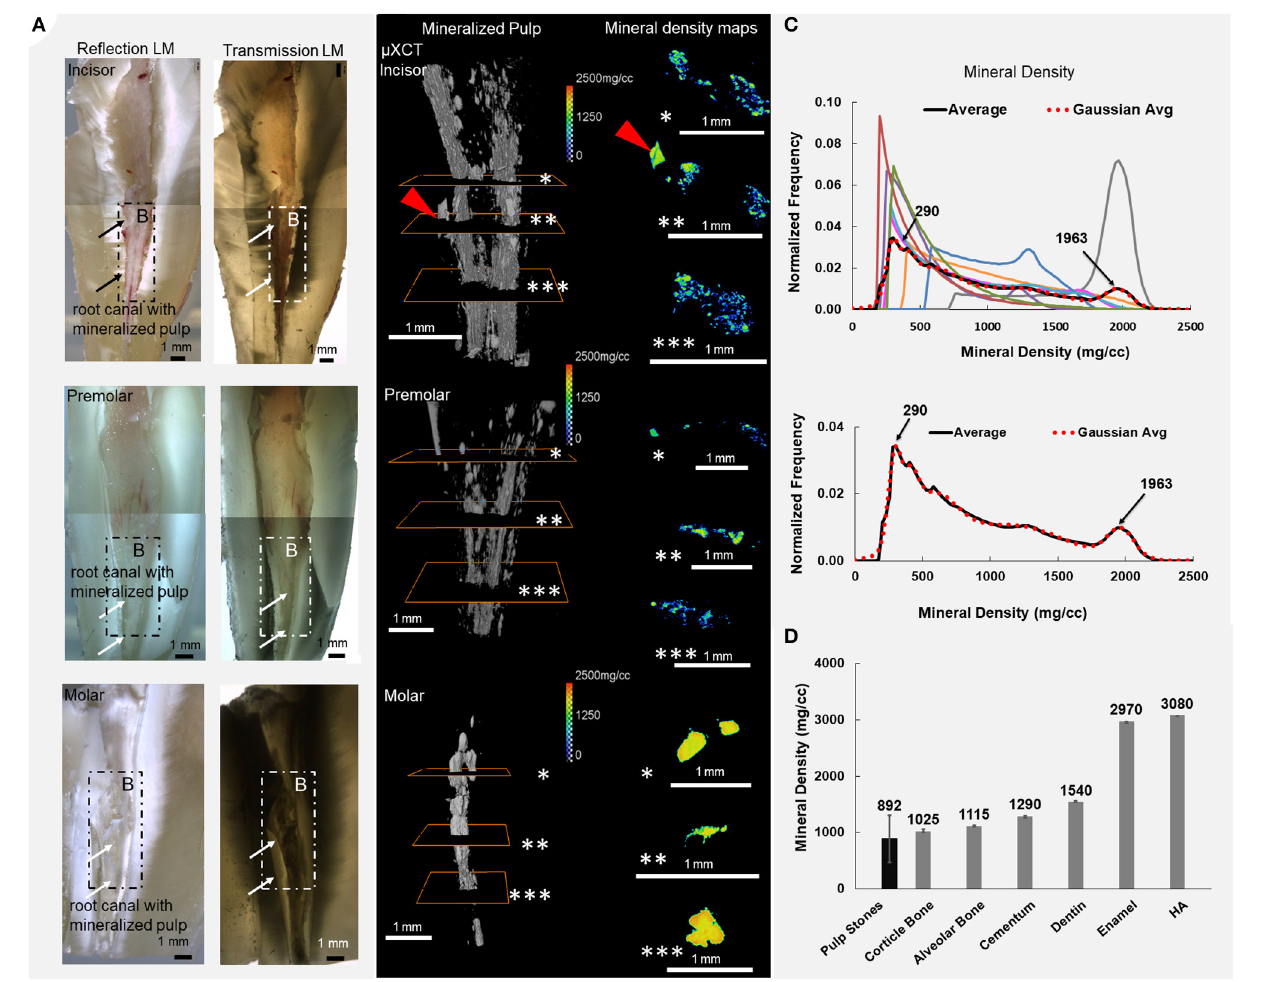
FIGURE 1 | The density of minerals in a unit volume of mineralizing pulp are heterogeneously distributed regardless of tooth type: the incisors, premolars, and molars. (A) Reflection and transmission light micrographs of sectioned teeth illustrate white and dark regions around the root canals (arrows point to the location of the pulp). (B) Varying mineral densities (MD) in digitally segmented volumes of mineralized pulp become apparent in the transverse sections (asterisks *, **, ***) of pulp (red arrowhead points to dentin-pulp interface—see Figure 3 ). (C) Normalized frequency of MD of pulp and (D) comparison of mineralized pulp and other mineralized tissues from humans including enamel, dentin, cementum, alveolar bone, hydroxyapatite (HA), and cortical bone are shown. The colored MD curves are